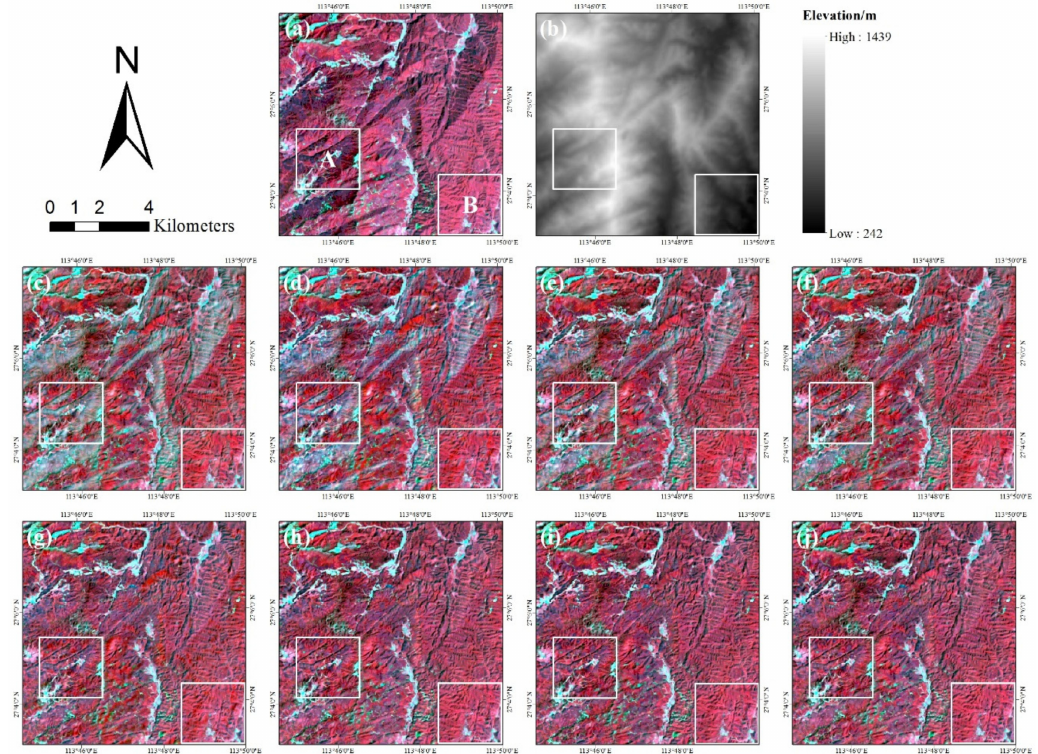
Figure 3. The topographic correction results of the yellow rectangle region shown in Figure 2 obtained by the traditional TC methods and the TC methods considering LPE. ( a ) The original image, ( b ) DEM, and the results obtained by ( c ) MIN, ( d ) CC, ( e ) SCSC, ( f ) SEC, ( g ) LPE-MIN, ( h ) LPE-CC, ( i ) LPE-SCSC, and ( j )